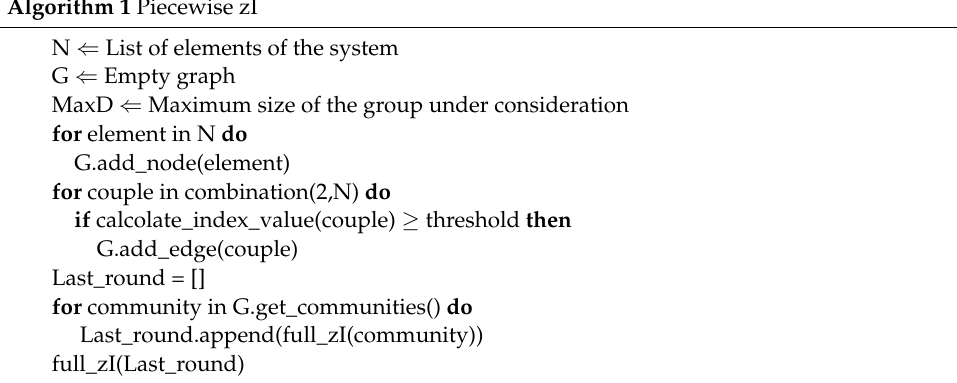
Algorithm 1 Pseudocode of the piecewise zI algorithm. Combination(k,N) returns